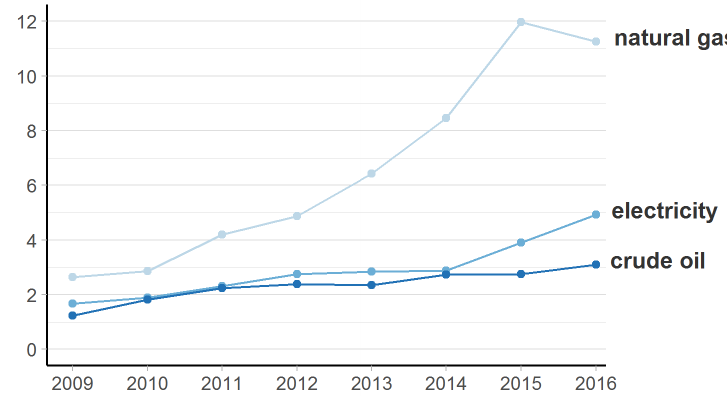
Figure 6. Growth rate of prices for certain types of energy resources for commercial energy consumers in Ukraine in the national currency relative to 2007. Source of information: [88].